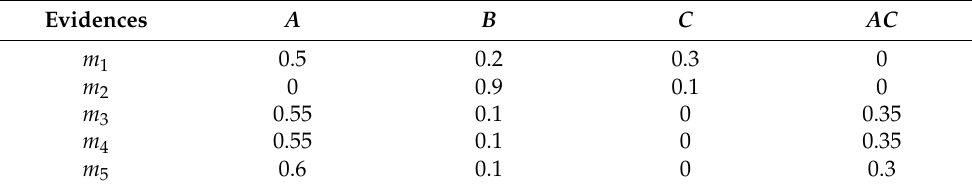
Table 6. Multi-focus evidence body data distribution.